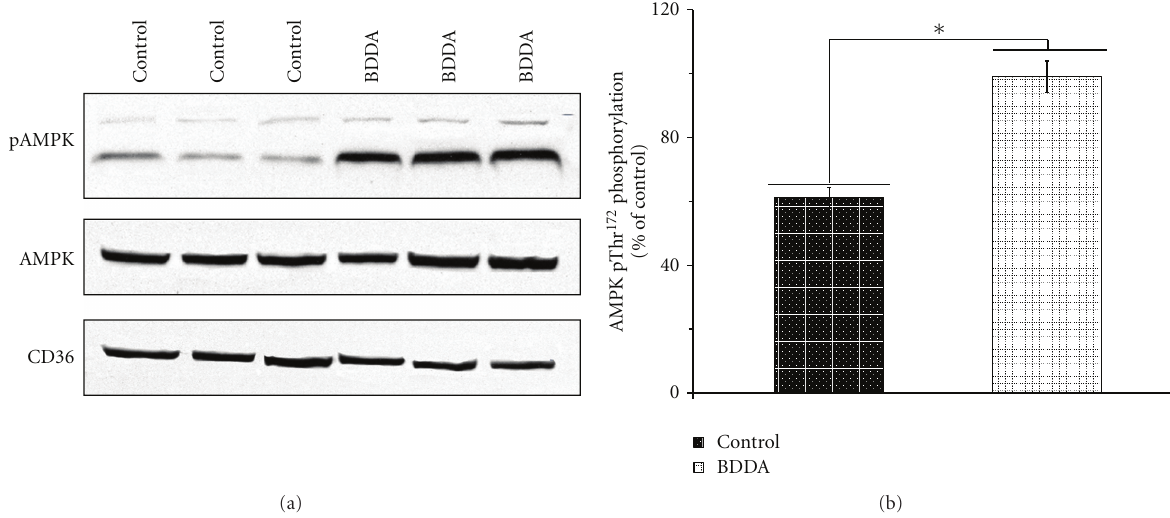
Figure 2: (+)- Z -BDDA enhanced hepatic AMPK phosphorylation in female OZR rats. Liver extracts were prepared and proteins separated by SDS page as previously described [10]. Following incubation with primary and secondary antibodies (Santa Cruz), immunoblots were developed with SuperSignal West Pico Chemiluminescent Substrate (Thermo Scientific). X-ray film densitometry was used for quantification (BioSpectrum Imaging System) and analysis (VisionWorksLS, UVP). All measures were obtained from female OZR rats after 11 weeks of (+)- Z -BDDA treatment ( n = 4). (a) Hepatic AMPK phosphorylation (AMPK1/2 Thr 172 ), total AMPK (AMPK α 1/2 H-300), and CD36 (H- 300) are presented as representative blots from control and (+)- Z -BDDA groups; (b) all displayed values represent percentage of control (means ± SE). Significant di ff erences between groups were determined by Student’s t -test ( P < 0 . 05) and indicated by asterisk ( ∗